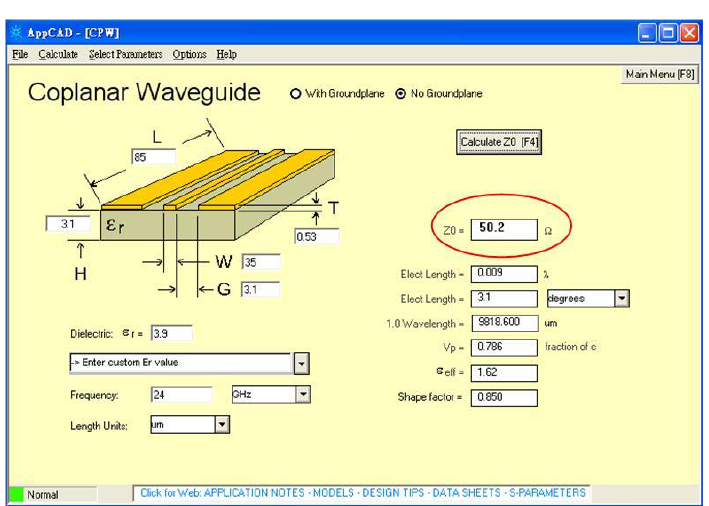
Figure 5. Simulation of characteristic impedance for the CPW.